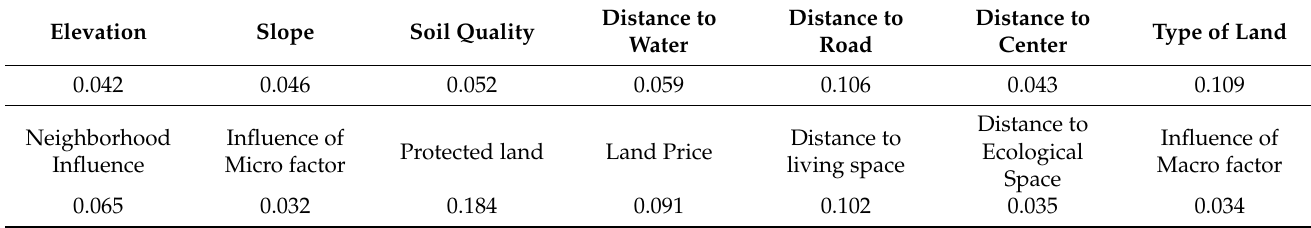
Table 6. Initial weight determination results of factors in production space evolution